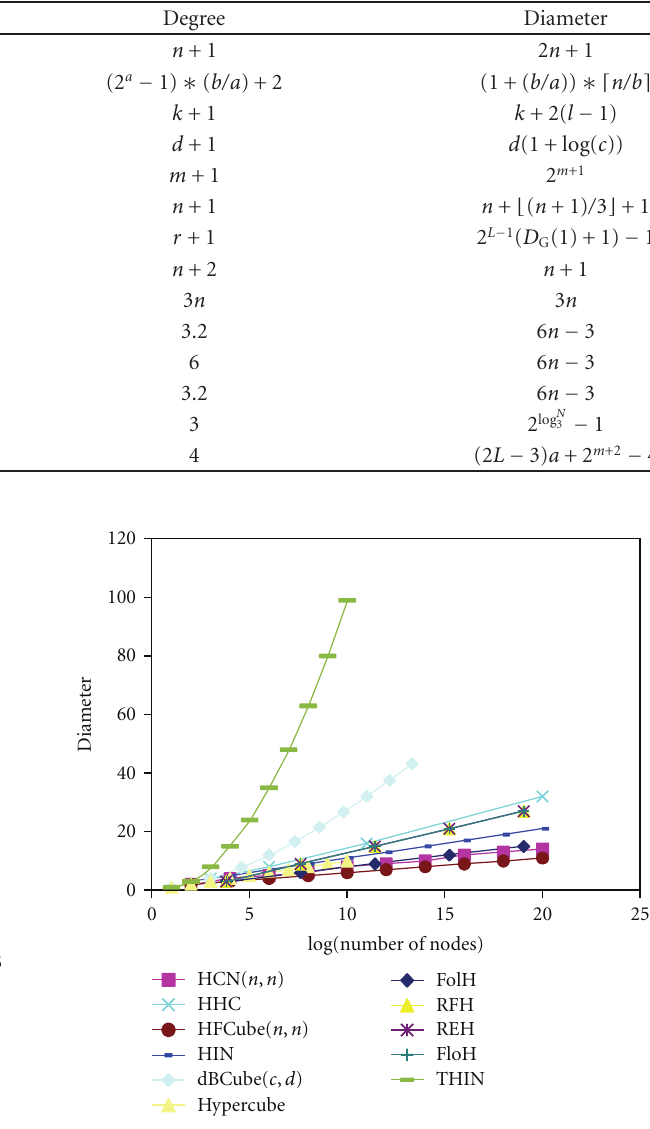
Figure 21: Comparison in terms of the